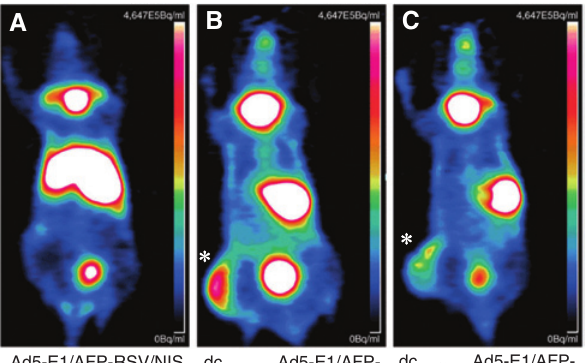
Figure 5: 124 I-PET images after intravenous injection of the uncoated virus vector (Ad5-E1/AFP-RSV/NIS) (A) and the adenovirus coated with PAMAM-G2-PEG-GE11 (dc300/GE11Ad5-E1/AFP-RSV/NIS) (B,C). By pretreatment with the monoclonal anti-EGFR antibody cetuximab, accumulation at tumor was significantly reduced. The stars indicate the tumor area. Reproduced from Ref. (85). Copyright ©2013, Rights Managed by Nature Publishing